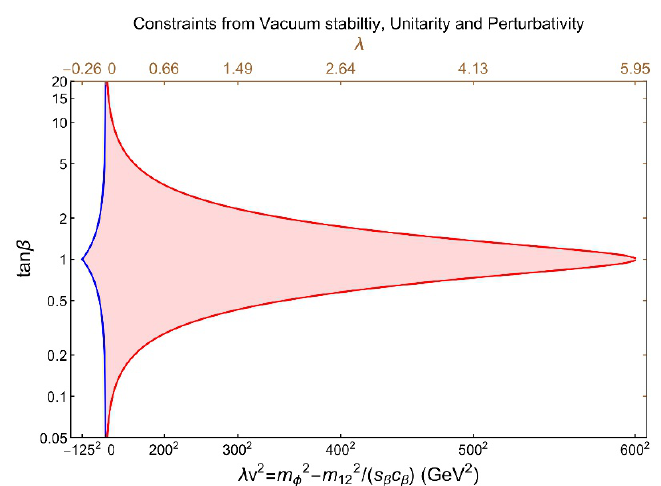
Figure 5 . The shaded region indicates the surviving region of 2HDM parameter space of tan (cid:12) vs. (cid:21)v 2 , after vacuum stability (blue lines), unitarity and perturbativity (red lines) are taken into account. The corresponding values of (cid:21) are shown in the upper axis. Here we took the simpli(cid:12)cation of m = m H = m A (cid:17) m (cid:30) and alignment limit of cos( (cid:12) (cid:0) (cid:11) ) = 0. H (cid:6)